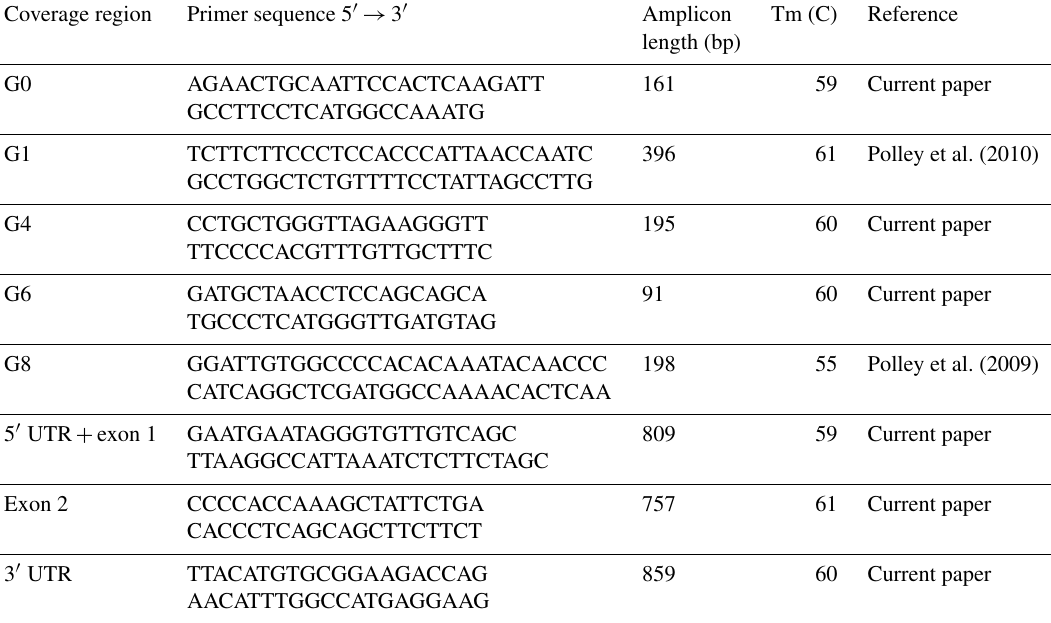
Table 3. Primer pairs for mutation detection in the GDF9 gene of Iranian sheep based on NCBI accession reference AF078545. Coverage region Primer sequence 5 (cid:48) → 3